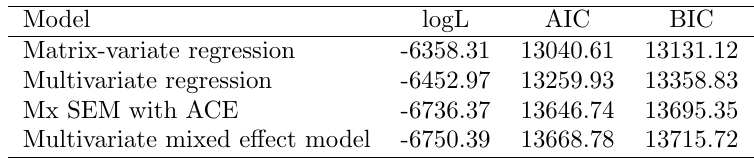
Estimation results of different models. The proposed matrix-variate regression analysis is compared with multivariate regression analysis, the structural equation models by Mx with ACE components and multivariate mixed effect model with random slopes. The statistics are: log-likelihood, the Akaike’s Information Criterion and the Bayesian Information